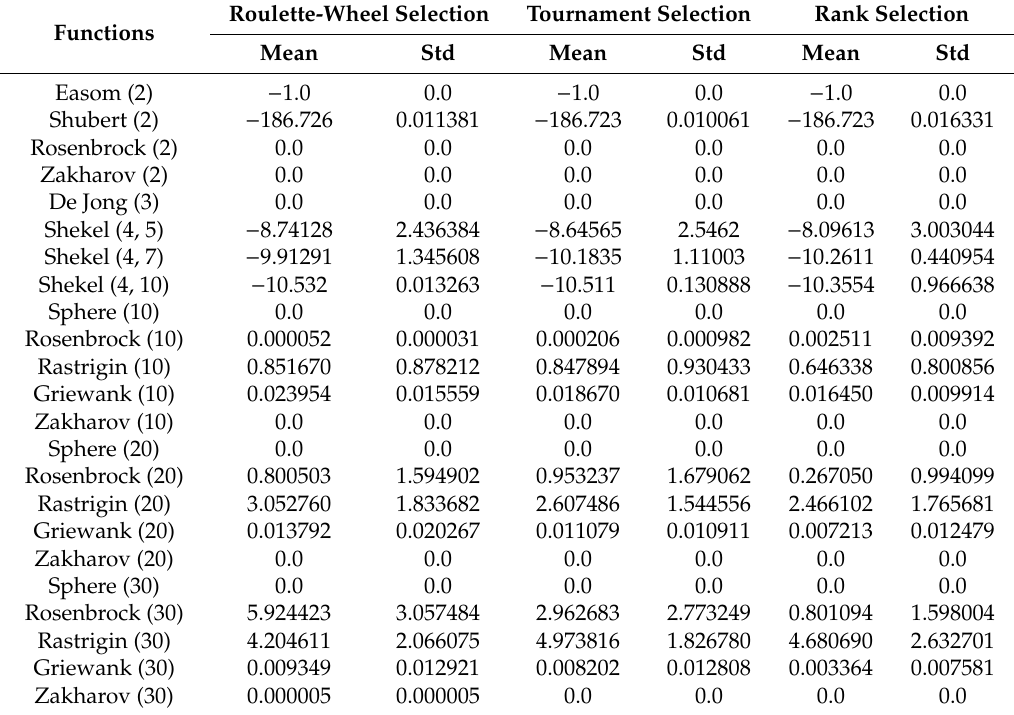
Table 3. The mean best function value and the standard deviation obtained by using various selection